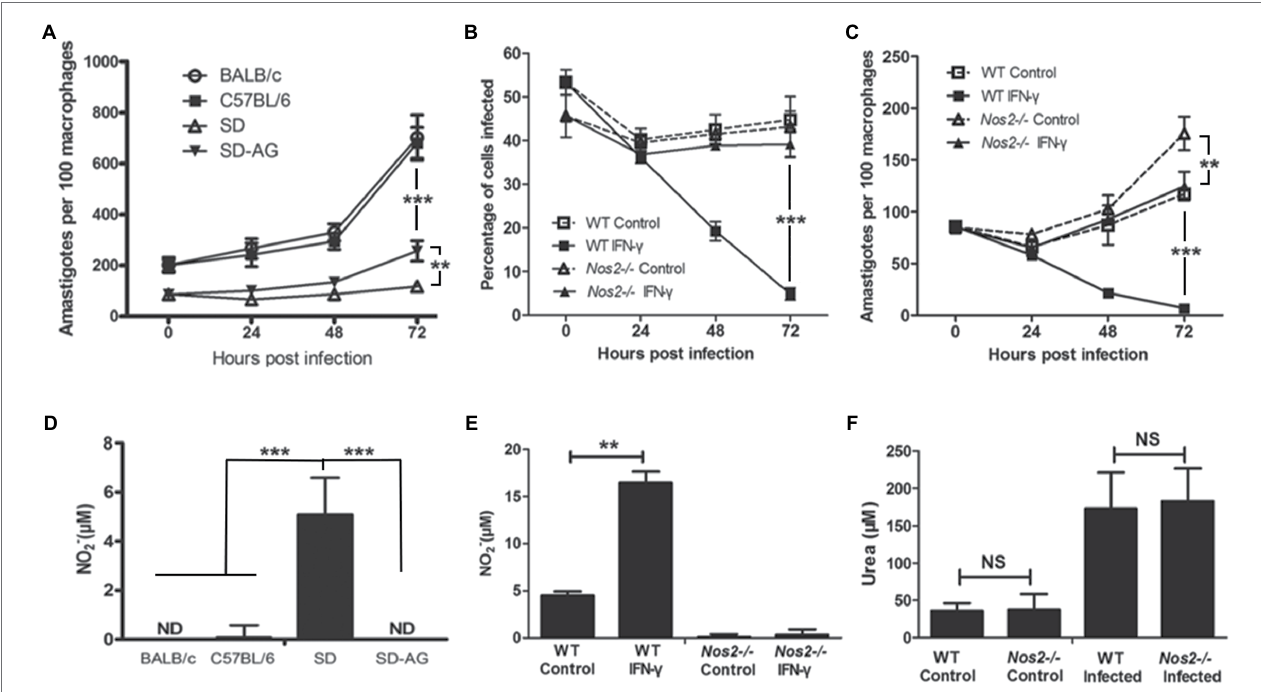
FIGURE 1 | NOS2 activity is indispensable for rat macrophage resistance to L. amazonensis infection in vitro . A,C , Peritoneal macrophages from BALB/C, C57BL/6 mice, wild-type SD rats (SD, WT), or Nos2 − / − SD rats ( Nos2 − / − ) were incubated with L. amazonensis promastigotes, with 5 mm aminoguanidine (AG) or 50 ng/ml recombinant rat IFN- γ , if indicated. The number of amastigotes per 100 macrophages (A,C) and percentage of macrophages infected (B) were shown. (D,F) , Corresponding NO production (D,E) and urea production (F) in culture supernatants at 24 h postinfection were determined. The data (mean ± SD amastigotes per macrophage) were derived from a single representative of three independent experiments. **indicates a significant difference (0.001 ﹤ P ﹤ 0.01), ***( P ﹤